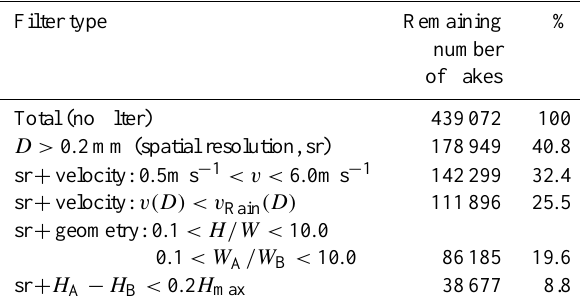
Table 3. Contribution of detected hydrometeors after applying the original matching algorithm. D is the maximum dimension, v the vertical velocity and H A / B and W A / B are the width and height mea- sured in camera A and